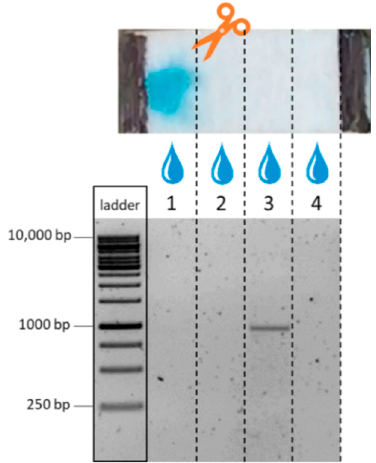
Figure 9. Separation of DNA fragment (910 bp) from HRP as representative of a potential protein contamination. Detection of the HRP after fiber-electrophoresis with crocodile clamps by TMB/H 2 O 2 substrate oxidation to a blue color at the sample loading zone and detection of migrated DNA by elution and subsequent agarose gel electrophoresis from the third quadrant of the chip area.